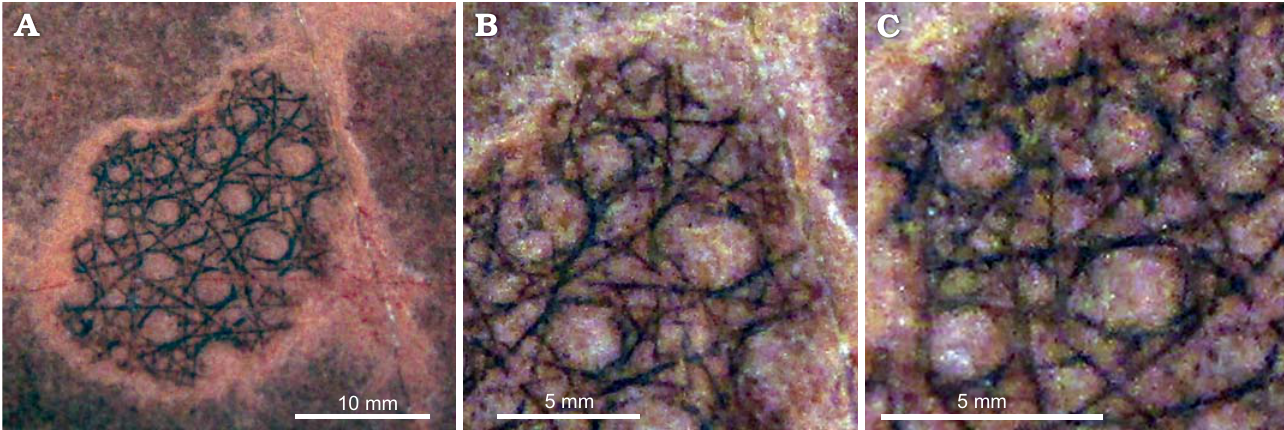
Fig. 4. Holotype UNAM 953 of the reticulosan sponge Ratcliffespongia arivechensis sp. nov. from the middle Cambrian El Mogallón Formation at Cerro El Mogallón, Sonora, Mexico. A . Skeletal layer with larger circular to elliptical parietal gaps. B . Detail showing reticulation of single skeletal layer. C . Enlargement showing that larger-order spicules are locally oriented with closely-spaced, aligned rays, combining to form straight or sinuous bundles.